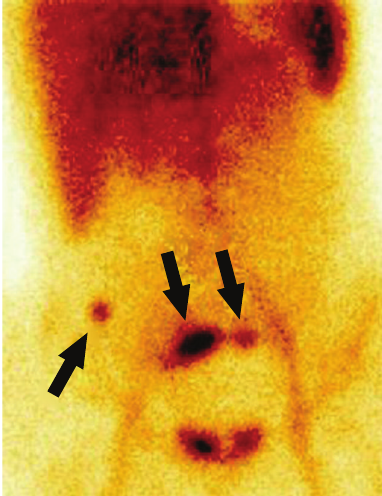
Figure 2: 52-year-old man with enterorrhagia. 99 m Tc-RBC scintig- raphy, anterior view, 15 minutes after intravenous injection of the radiotracer. Bleeding at the site of an A-V malformation in the proximal jejunum ( arrow head